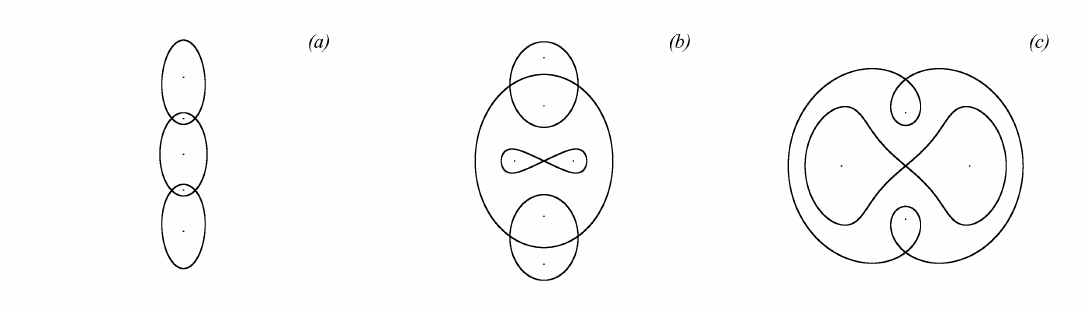
Figure 23. Phase portraits of the stationary advection system Equation (62) given µ 1 = µ 2 = 0.3 and Ω = − 0.02 as the absolute value of the strain intensity is being decreased, S 0 and ( c ) −